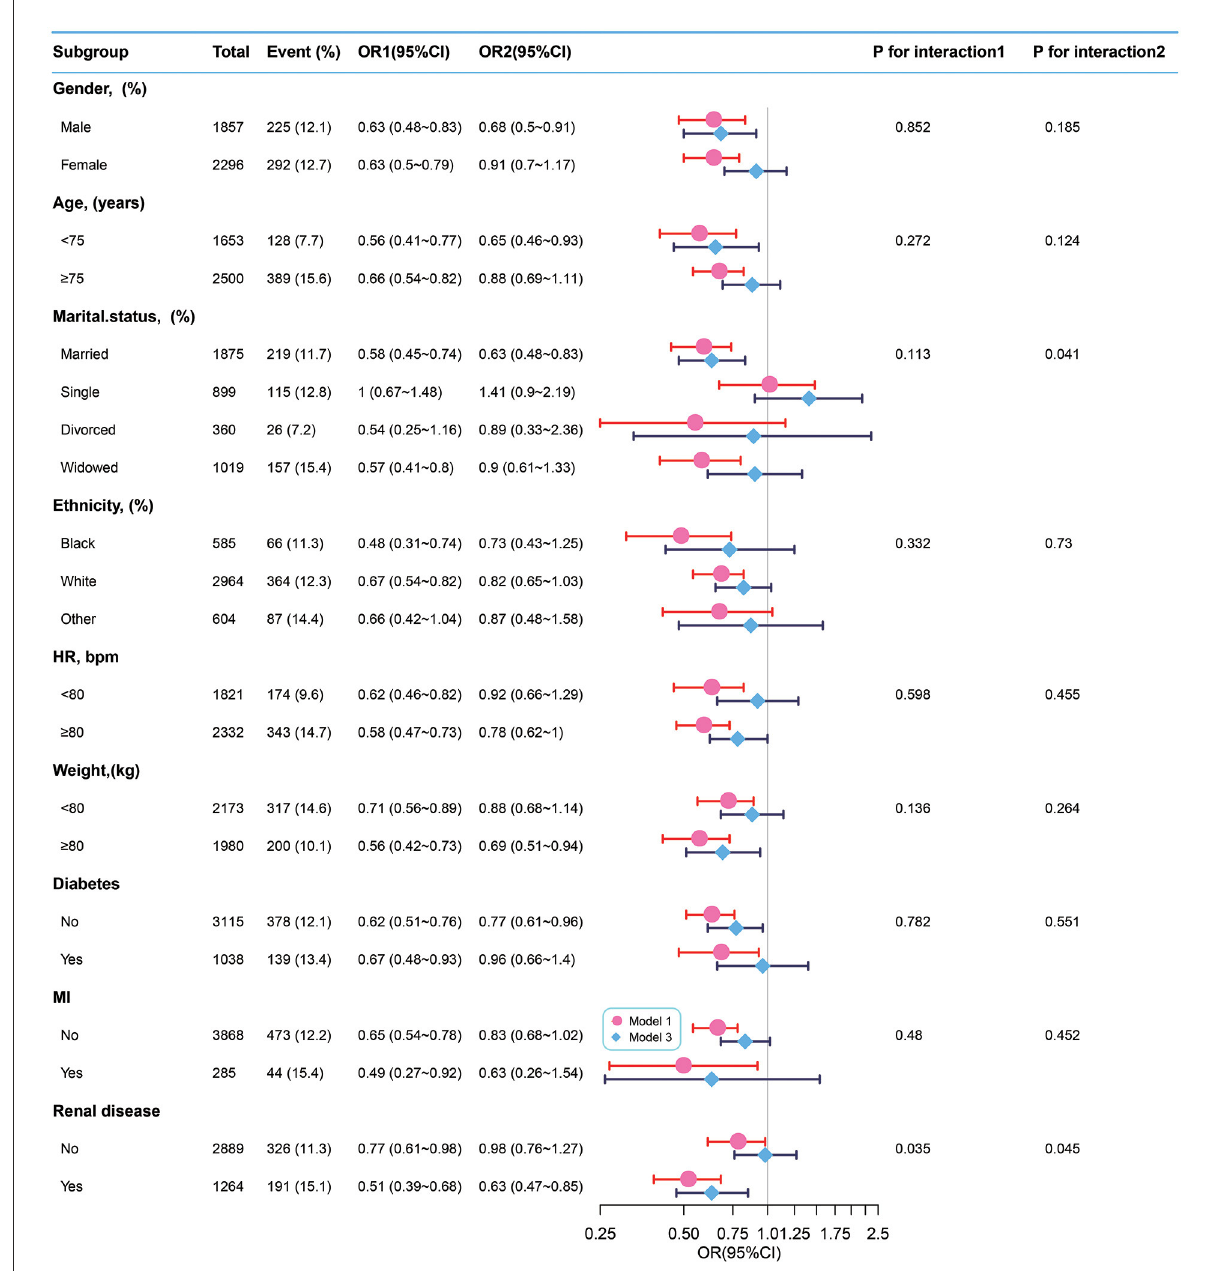
FIGURE3 Subgroup analyses of BT and 28-day ICU mortality and in-hospital mortality. Adjustment factors included gender, age, marital status, ethnicity, weight, WBC, albumin, BUN, INR, PTT, anion gap, bicarbonate, calcium, chloride, sodium, HR, SBP, DBP, MBP, RR, SpO2, the presence of renal disease, the presence of severe liver disease, the presence of malignant cancer, the presence of myocardial infarction, the presence of cerebrovascular disease, the presence of peripheral vascular disease, the presence of diabetes, the presence of chronic pulmonary disease, and CCI. BT, body temperature; HR, heart rate; MI, myocardial